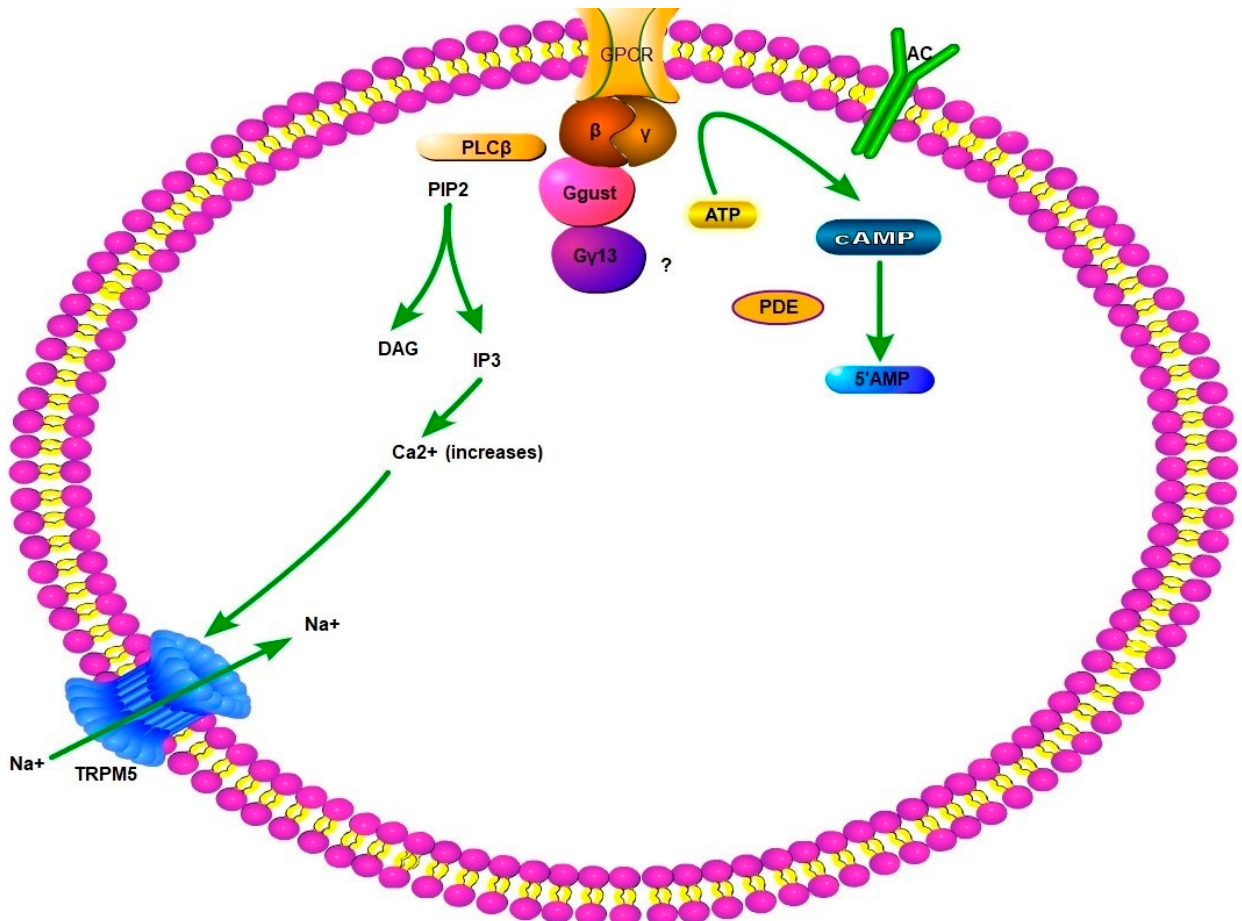
Figure 3. General mechanism of intracellular gustatory response. When tastant molecules combine with trans-membrane GPCR and the complex cytosolic subunit of βγ , Ggust, and G γ 13 cause conversion of ATP and PIP2 (with PLC β , phospholipase C β ) into cAMP and IP3, respectively. This IP3 mediated the increase of Ca 2+ inside the cell through opening of channels in the Ca 2+ storing organelles of cell, i.e., endoplasmic reticulum (not shown in the figure). This increased Ca 2+ opens the TRPM5 channels which allow entry of Na + ions. Both these positive ions change the membrane potential. Similarly, conversion of ATP into cAMP causes opening of AC channels which affects the downstream channels which may be similar to olfactory transduction signaling pathway. PLC β , phospholipase C β ; PIP2, phosphatidylinositol 4,5-bisphosphate; IP3, inositol 1,4,5-triphosphate; DAG, diacylglycerol; ATP, adenosine triphosphate; cAMP, cyclic adenosine monophosphate.